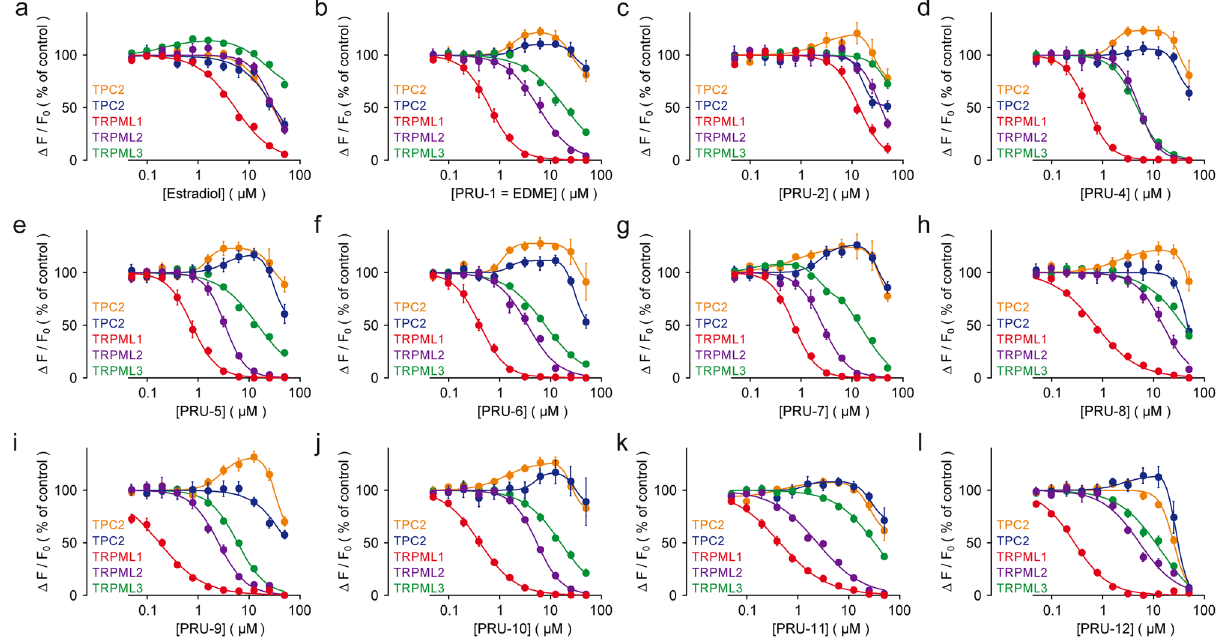
Figure 4. Estradiol, EDME and analogs in Fluo-4 calcium imaging experiments. ( a – l ) Concentration-effect relationships for Ca 2+ increases (Fluo-4) in response to different concentrations of EDME, estradiol and analogs on HEK293 cells stably expressing hTRPML1∆NC-YFP, hTRPML2-YFP, hTRPML3-YFP or hTPC2L11A/L12A- RFP 22,24 . Cells were activated with ML-SA1 (5 µM) for TRPMLs or TPC2-A1-N (10 µM; blue) and TPC2-A1-P (30 µM; orange) for hTPC2. Data are calculated from 3 to 5 independent experiments, each, and represented as means ± SEM. IC 50 values are presented in Table